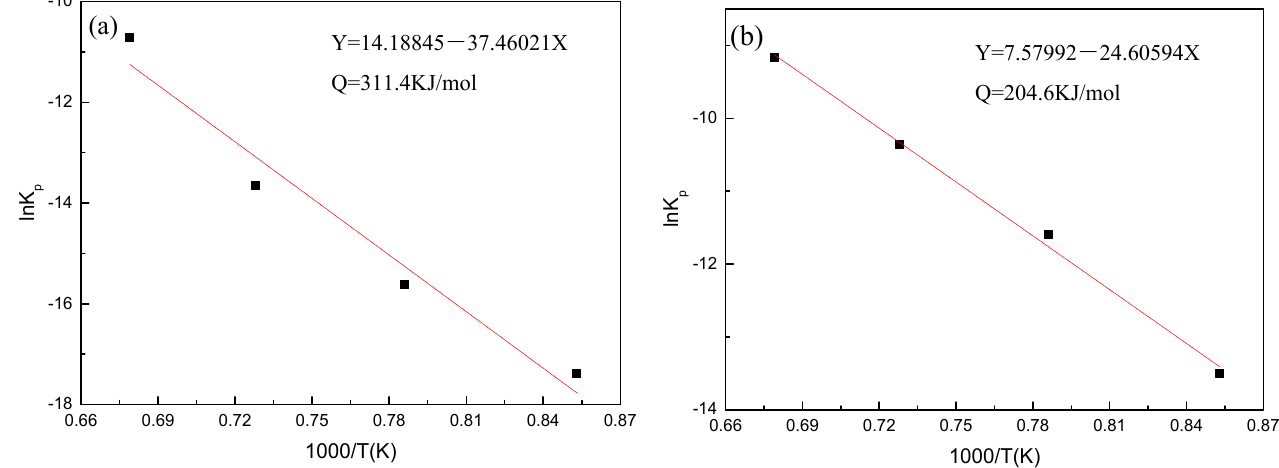
Figure 5. Fitting curve of ln K p and 1000/ T of Fe–10Cr steel in different atmospheres. ( a ) Air; ( b ) air + 50% water vapor.